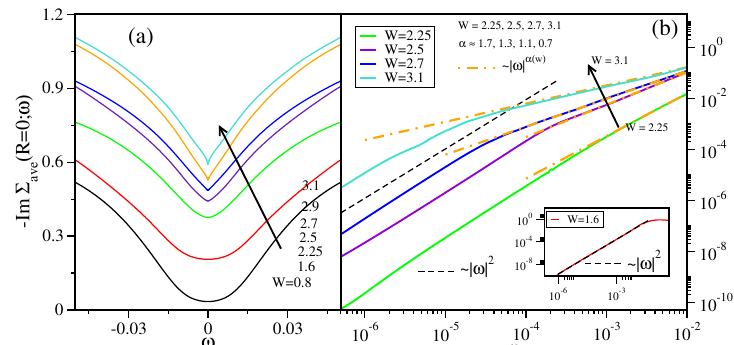
Figure 43. The negative of the imaginary part of the low-frequency ( ω ) self-energy as a function of ω on a linear (a-panel) and log-log scale (b-panel) for various disorder values (legends), N c = 38 and Im Σ ( ω ) is quadratic close to the Fermi level and crosses U = 1.6. The left panel shows that the − over to a power law form (see more clearly in the right panel) with an exponent α ( W ) < 2, that is disorder-dependent.